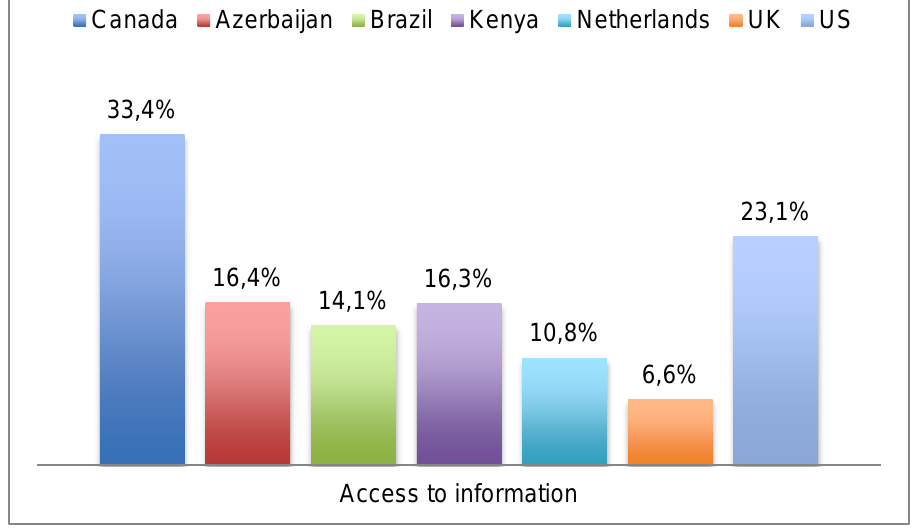
Figure 1: Salience of the code “Access to information” by country Action Plan Similarly, aligning with traditional definitions of open government, accountability is the top most salient theme in four of the seven countries, as can be seen in Figure 2. This represents 27.7 per cent of the total coded text in the Action Plan of Azerbaijan, 25 per cent of coded text in Brazil’s Action Plan, 38.6 per cent of Kenya’s Action Plan, and 32 per cent of the United States’ Action Plan. Accountability is the second most salient theme in the Canadian Action Plan, at 23.9 per cent of the coded text, and a close third in the Netherlands’ plan at 14.9 per cent of the coded text. The only country where this theme was not a dominant one was the United Kingdom, where it only occupied 6.9 per cent of the total text. However, even here, it is the fourth most identified